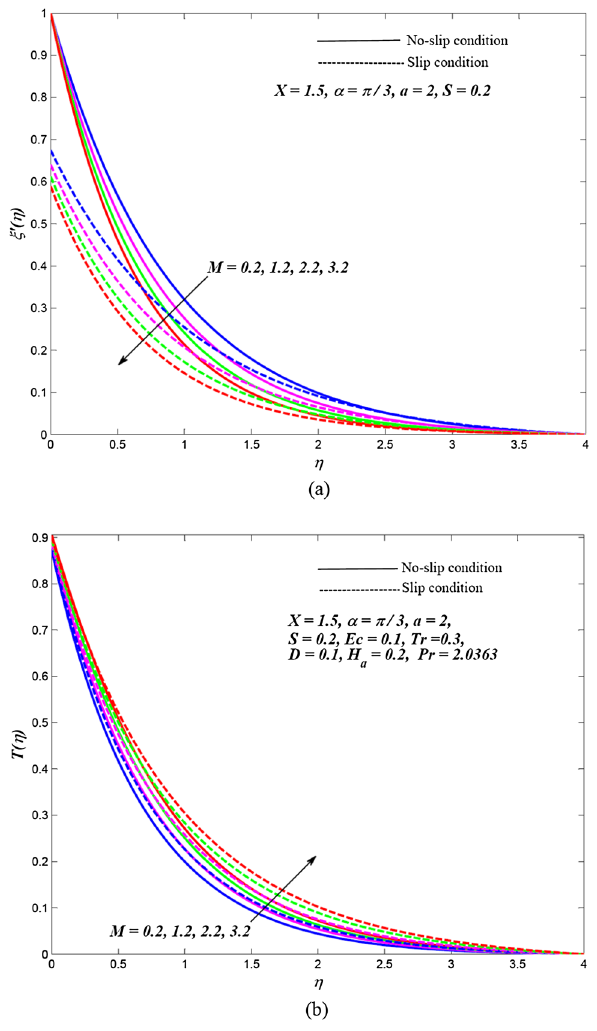
Figure 2. Effects of M on the dispersal profiles of hybrid ( a ) velocity ξ ′ (η) and ( b ) temperature T (η)